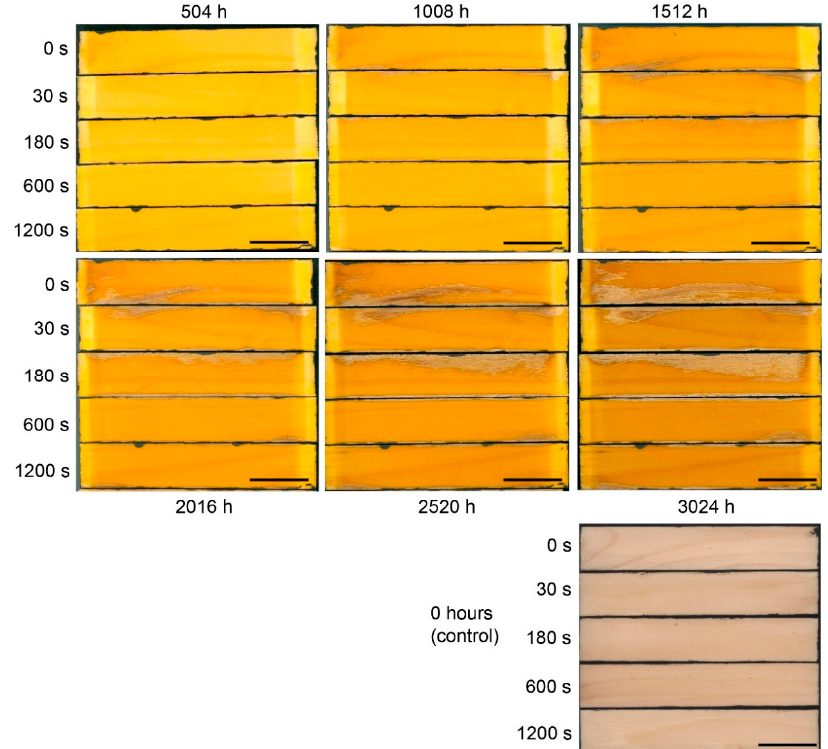
Figure 5. Effects of plasma treatments (0 [control], 30, 180, 600, and 1200 s) on the appearance and integrity of solvent-borne coating on tangential black spruce samples exposed to accelerated weathering for 504, 1008, 1512, 2016, 2520, and 3024 h. The appearance of a group of plasma-treated and coated samples that were not exposed to weathering (0 h) can be seen on the lower right of the figure. Scale bars = 15 mm.